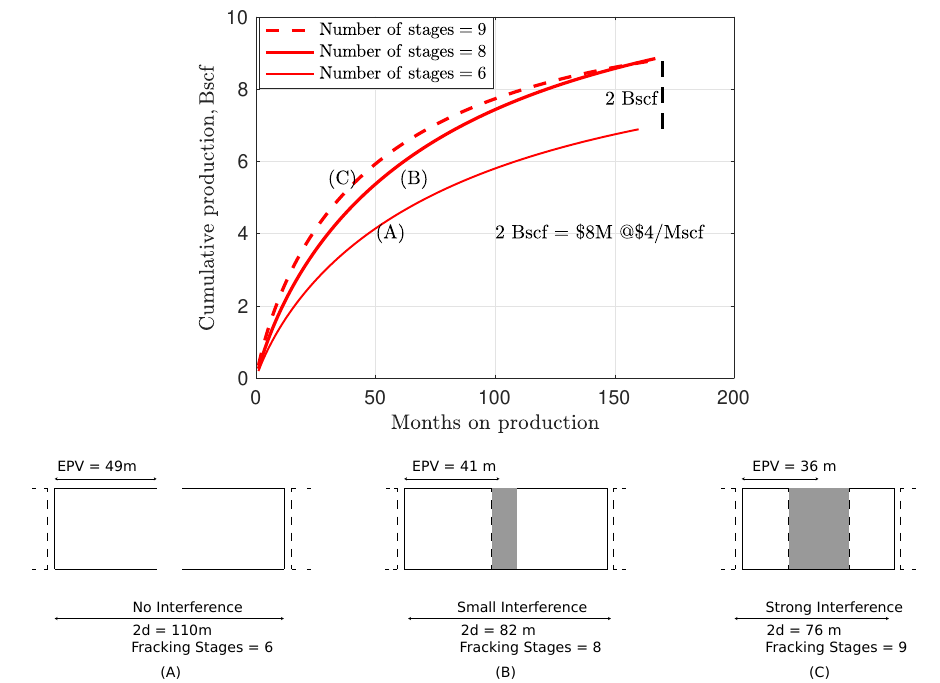
Figure 10. ( A – C ) represent three cases with different EPV length, tip-to-tip (2d) length, and number of fracking stages. The corresponding cumulative production for the three cases are also shown above. Curve (A) represents cumulative production of a Barnett well with the 660 m lateral, 6 frac stages, and the EPV width of 49 m. For 8 frac stages, the EPV width decreases to 41 m, and there is small interference, denoted by the shaded area, with a small effect on the flow properties. The cumulative production, Curve (B), increases by 2 Bscf. For 9 frac stages, the EPV width is 36 m and pressure interference is strong, thus affecting flow properties at the microscale. The matrix-fracture source term increases causing a steeper decline in pressure support. The incremental increase in cumulative production of Curve (C) with 9 frac stages compared with Curve (B) with 8 frac stages is negligible. Case 1: The number of frac stages is 8. For a fixed lateral length of a well, the width of effective stimulated volume (EPV) of each half of the stage is 41 m (660 m/(2 × number of frac